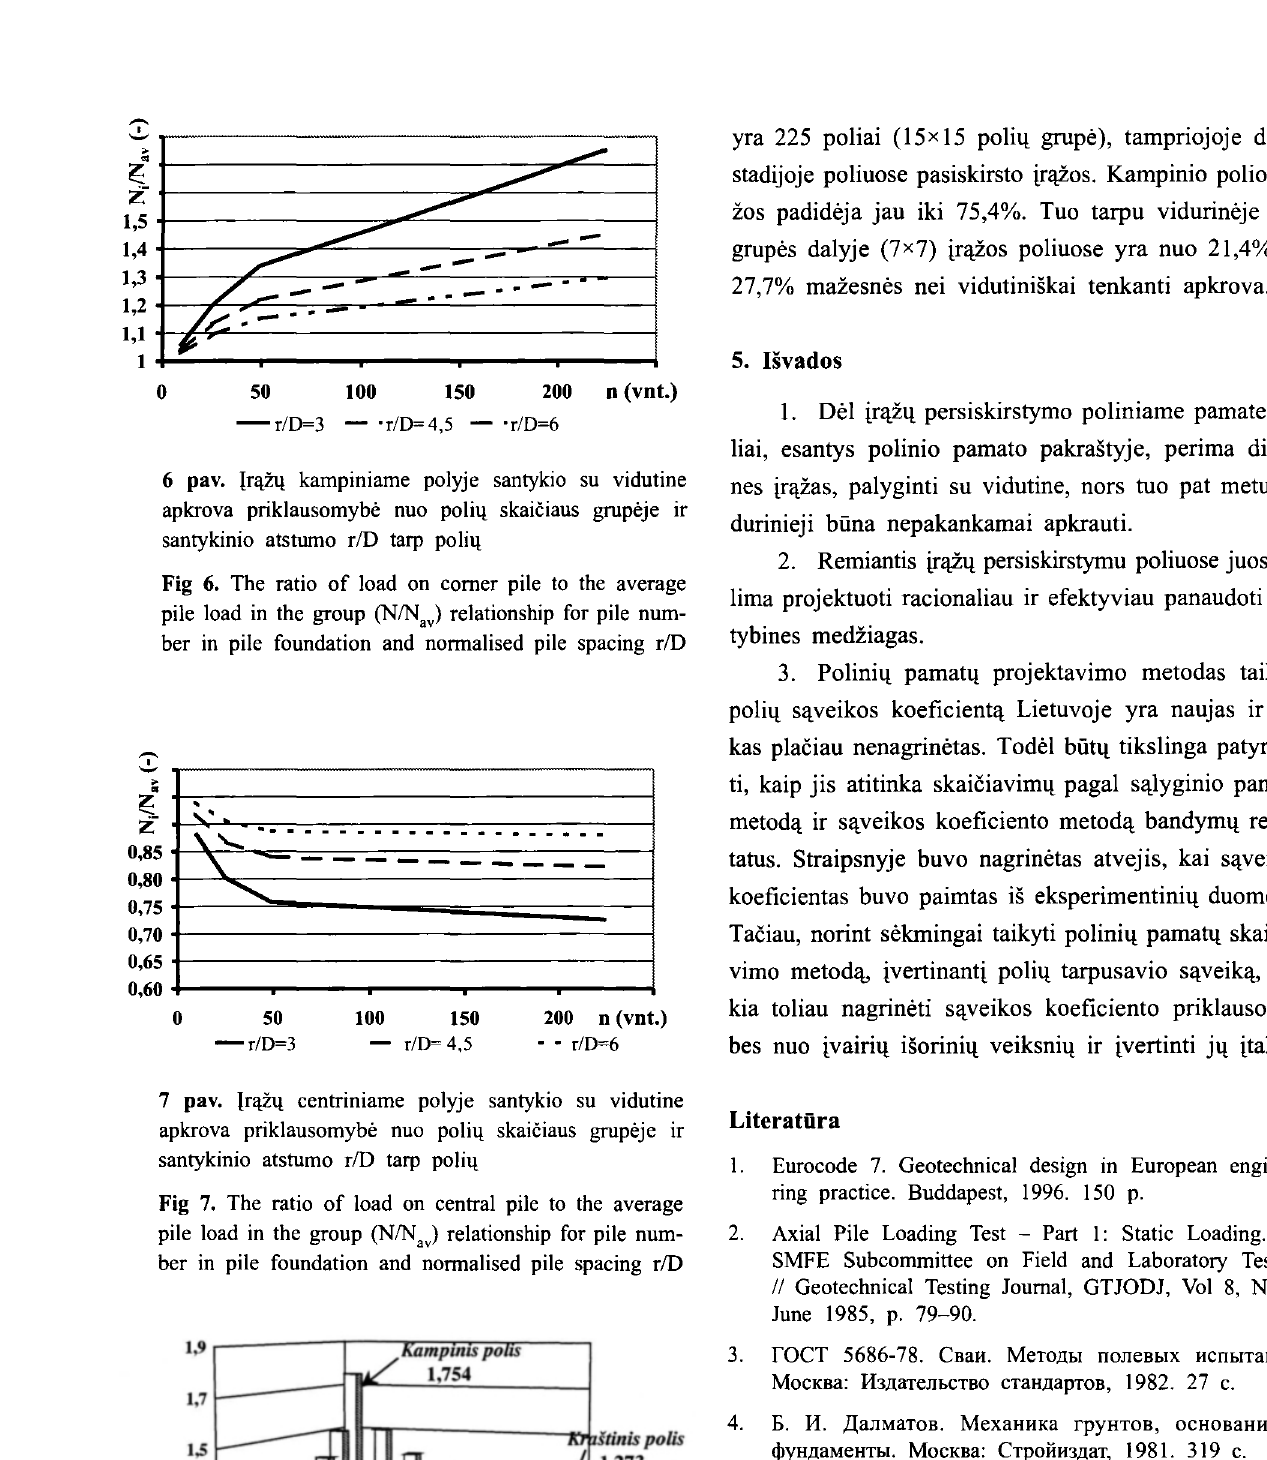
Fig 7. The ratio of load on central pile to the average pile load in the group (NIN.) relationship for pile num ber in pile foundation and normalised pile spacing riD